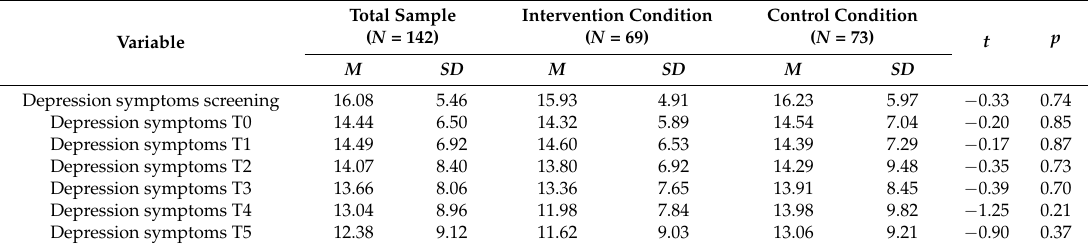
Table 2. Means, standard deviations, and t -values for differences on depression symptoms between the intervention and control